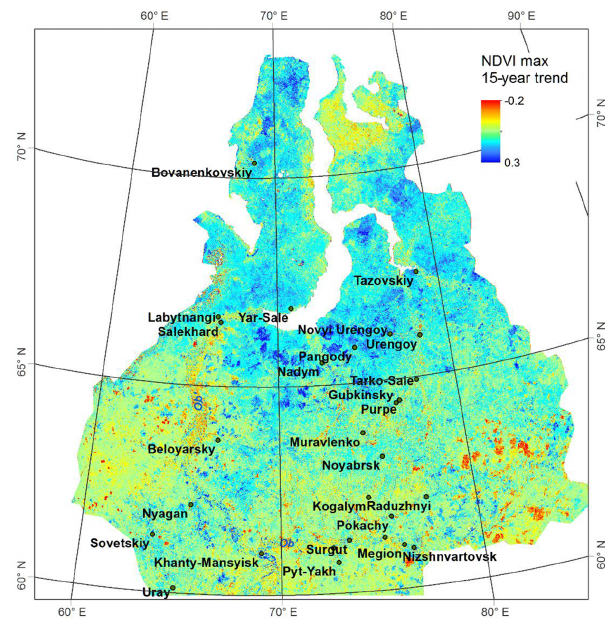
Figure 2. Linear trends in the annual maximum normalized dif- ference vegetation index (NDVI) obtained from analysis of the MODIS 0.25km data product for 2000–2014 over the north-western Siberia region in Russia. The trends are given in the NDVI changes per 15 years. The yellow colours show the decreasing NDVI, which corresponds to decreasing biological production; the blue colours show the increasing NDVI. More detailed analysis of the trends is given in Esau et al.